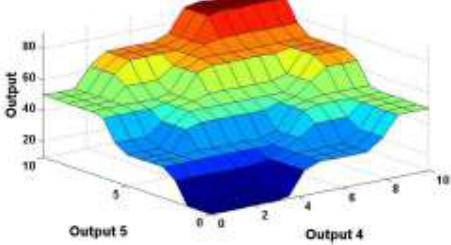
Figure 16. Surfaces of the fuzzy logic subsystem